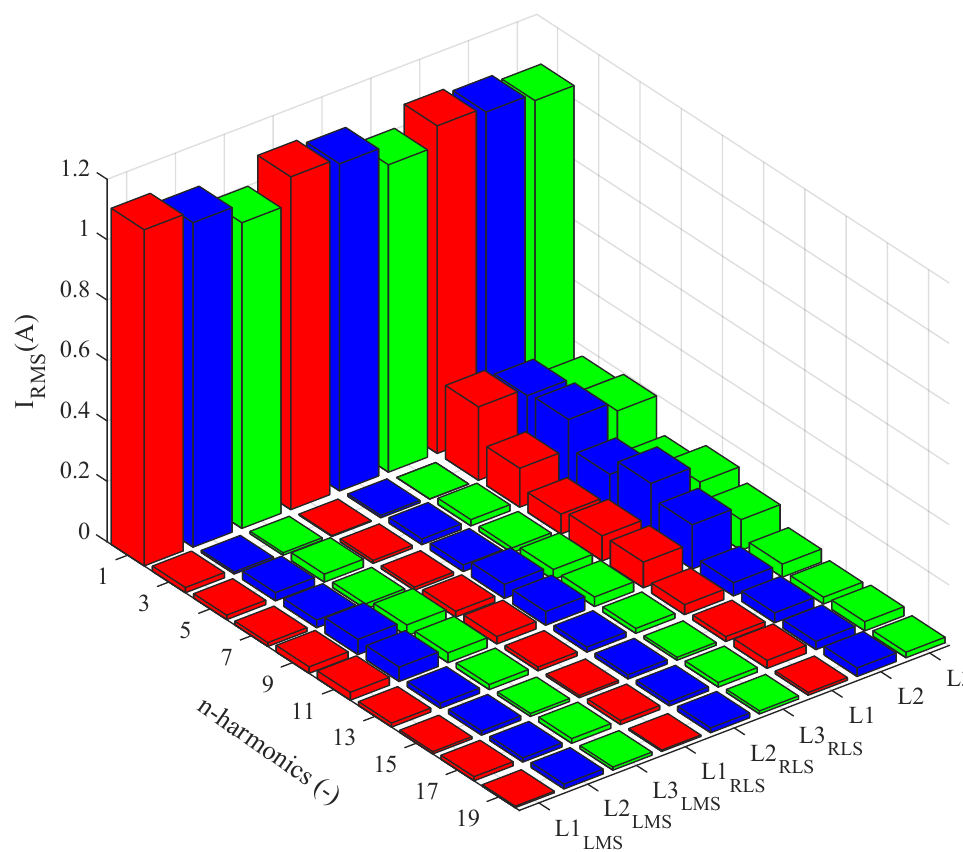
Figure 29. Switched on test polygon; current spectra before and after application of the adaptive LMS and RLS